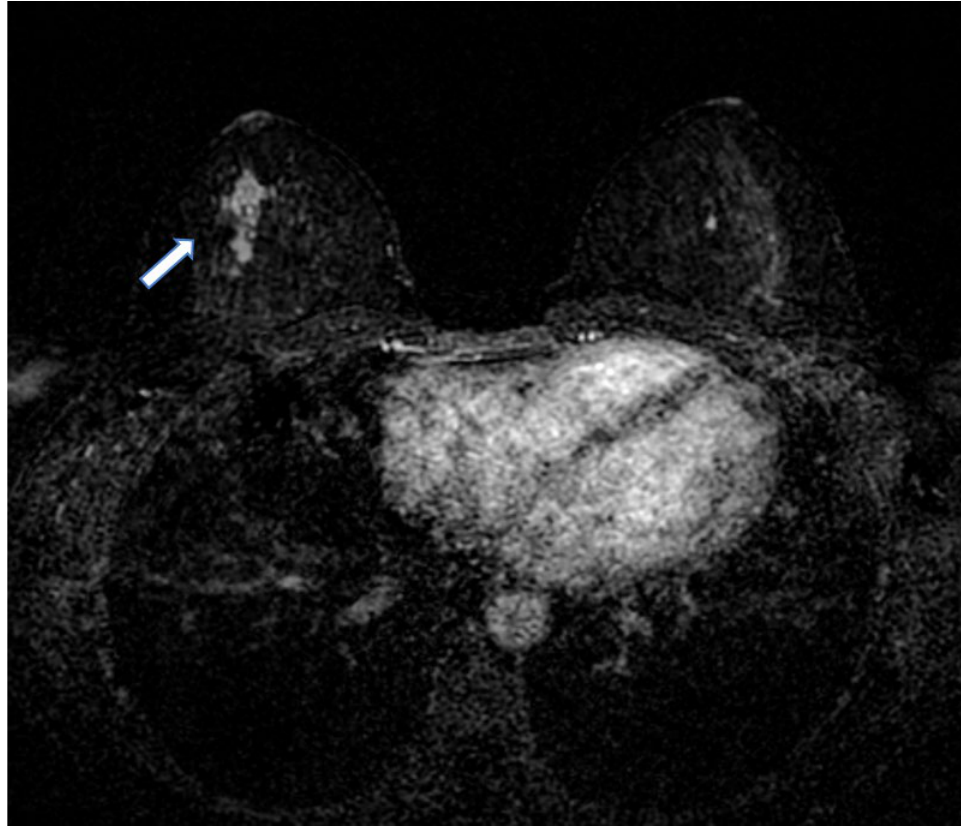
Figure 3. Breast MRI shows an enhancement (arrow) in the right breast suspicious for breast can- cer.